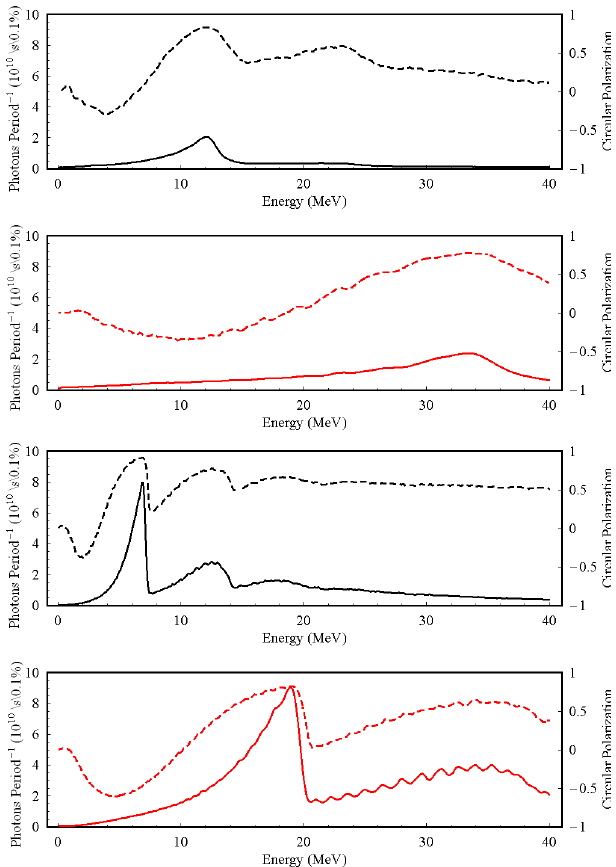
FIG. 17. (Color) Photon spectrum per period (solid) and circular polarization rate (dashed) from PM ring undulator (top) and SC undulator (bottom) for 150 GeV (black) and 250 GeV (red) energy electrons. Calculated using the measured magnetic flux density